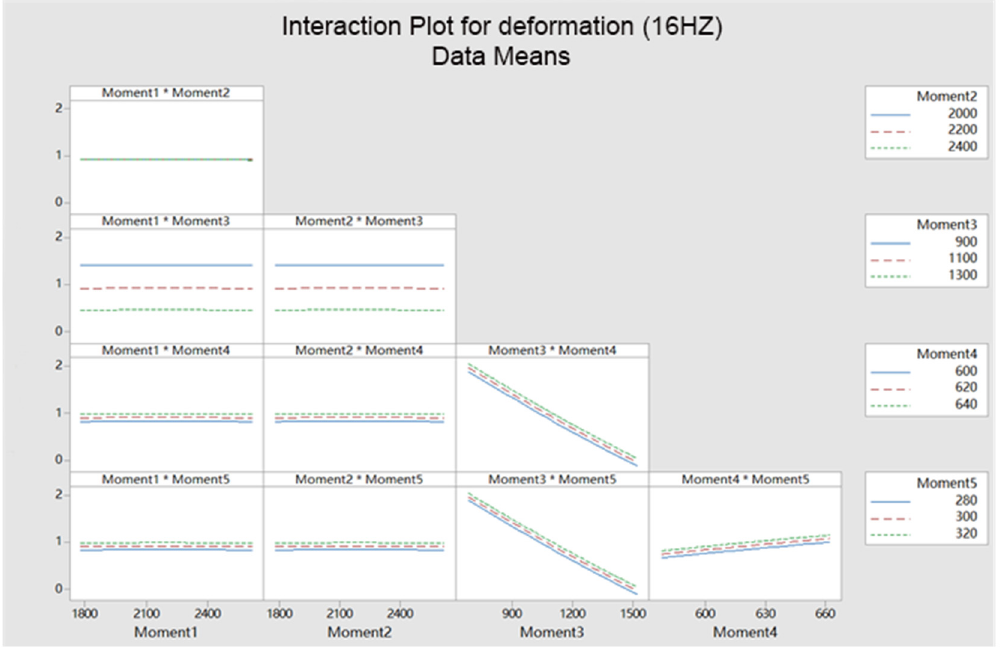
Figure 11. Main effect diagrams of maximum amplitude displacement at the end of a series-parallel controllable mechanisms welding robot.